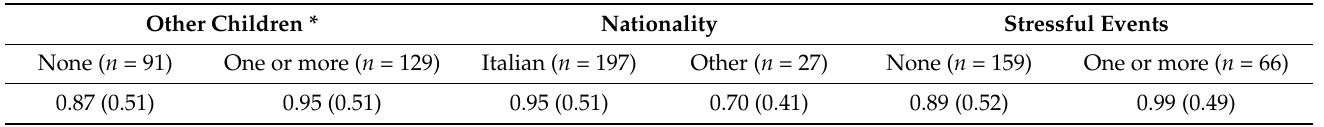
Table 3. Maternal scores on PAMA by group.